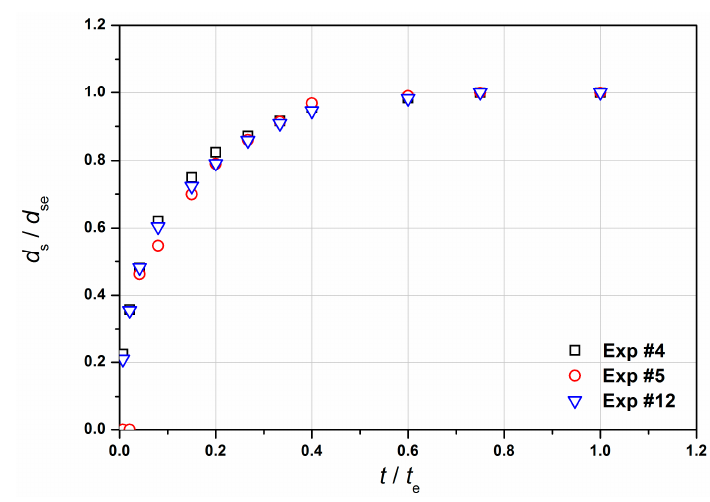
Figure 3. Evolution of scour depth with time using values normalized with equilibrium values.